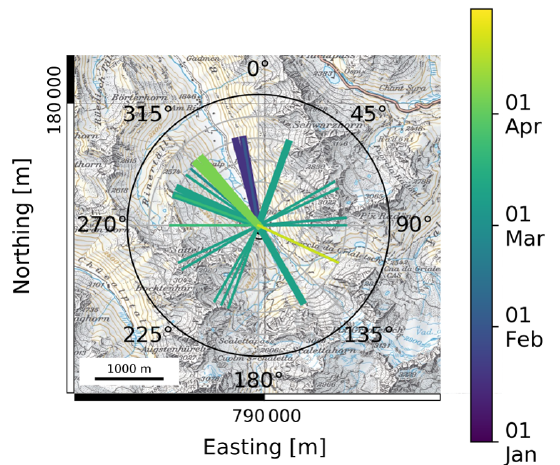
Figure 13. Polar plot representation overlaid on a map section of the field site. The angle represents the direction of the origin of the event, the thin lines represent events with a duration < 60s and the thick lines represent events with a duration ≥ 60s. The different colored lines represent the time of the year. Reproduced with per- mission from Swisstopo